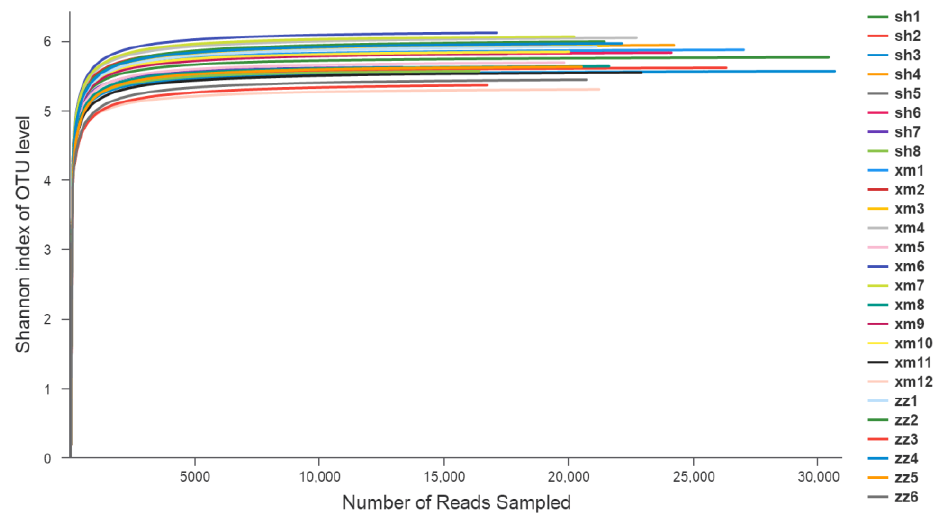
Figure 3. Shannon – Wiener curve of the component species in 26 samples. (sh: Shanghai; xm: Xiamen; zz: Zhangzhou).